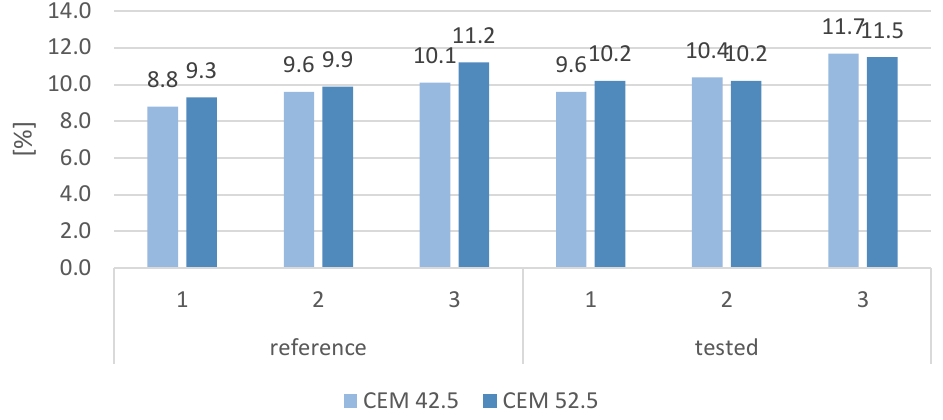
Figure 13. Water absorption of cement mortars, respectively, reference and subjected to cycling freezing and thawing in relation to cement grade.